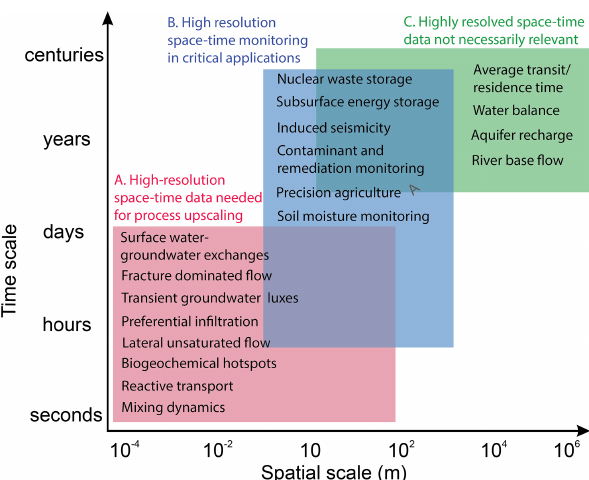
Figure 8. Indicative temporal and spatial scales of some processes in hydrogeology for which accurate mechanistic models are still lacking (in reddish colors), for which 4D monitoring might be cru- cial (blueish and greenish colors), and for which 4D might be un- necessary (grayish colors), see also Table